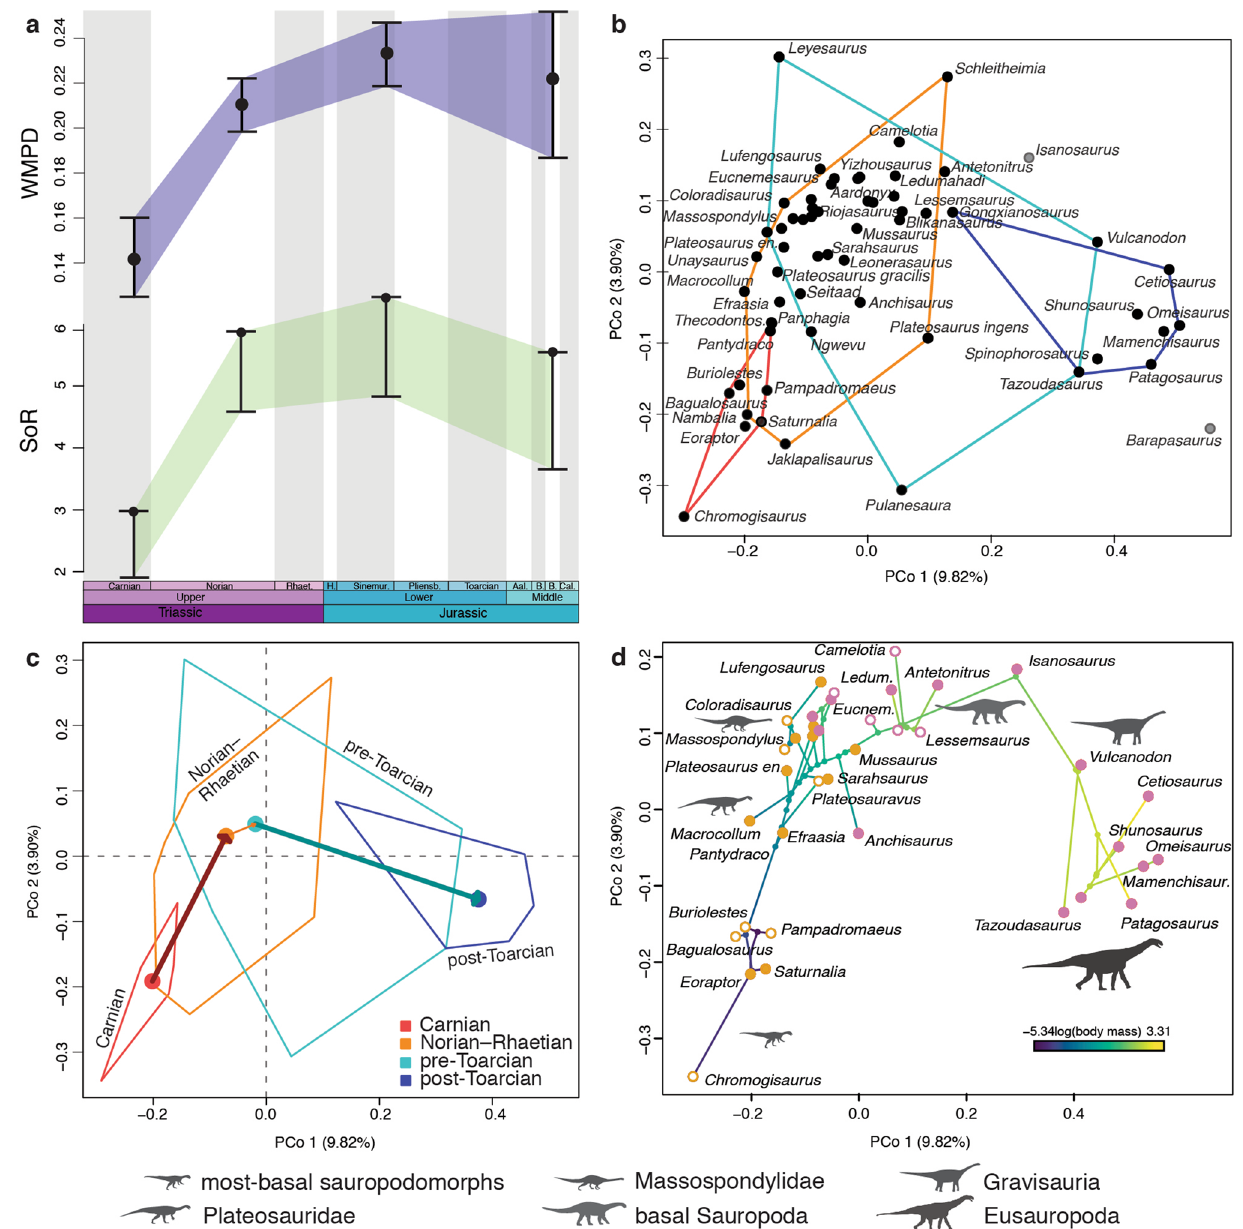
( b ) Morphospace distribution in the first two PCOs. Barapasaurus and Isanosaurus (greys circles) were excluded from time bin groups because their temporal uncertainty. ( c ) Displacement from the centroid of the previous time bin, in which the thickness of the arrows is proportional to the multidimensional distance of the displacement. ( d ) Phylomorphospace showing locomotion style (mapped in orange circles for bipedal and pink circles for quadrupedal) and body mass optimized through time (colours of branches). Empty circles represent assumed locomotion style based on Fitch optimization in the phylogenetic